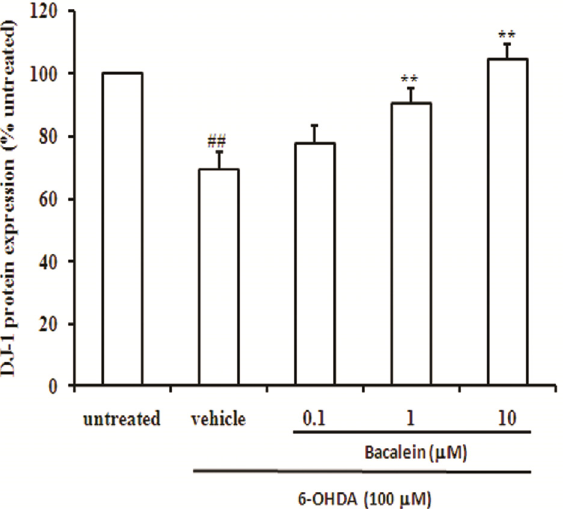
Figure 5. Effect of baicalein on DJ-1 protein expression in SH-SY5Y cells induced by 6-OHDA. Data were expressed as percentage of untreated